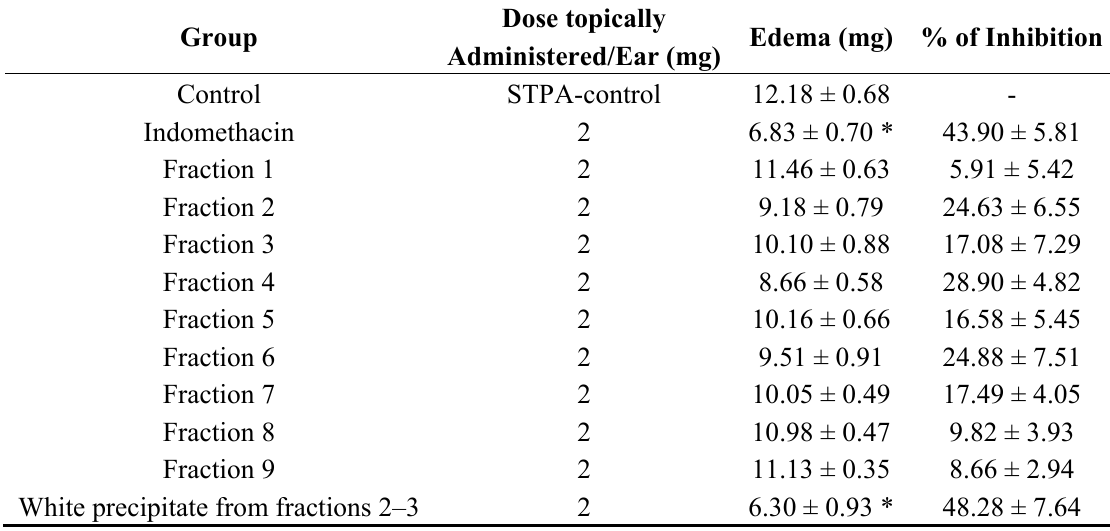
Table 3. Evaluation of the anti-inflammatory effect of the white precipitate from fractions 2 and 3 of Senna villosa leaves chloroform extract in TPA-induced ear edema. Dose Group